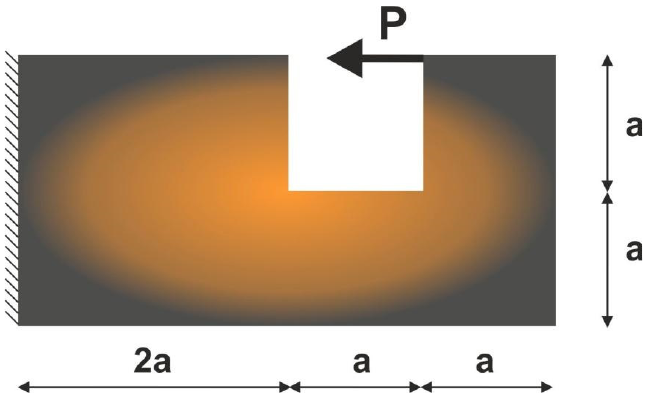
Figure 12. The test structure 2 with applied load and support.